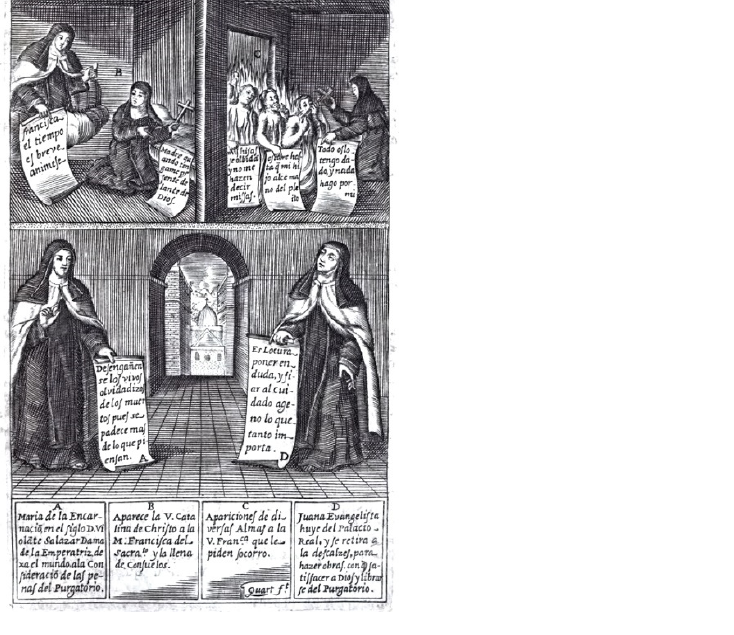
Figure 13. Quart. Revelaciones de la Venerable Madre Francisca del Santísimo Sacramento; María de la Encarnación y Juana Evangelista . Francisco de la Cruz, Cinco palabras del apóstol San Pablo … p. 52.